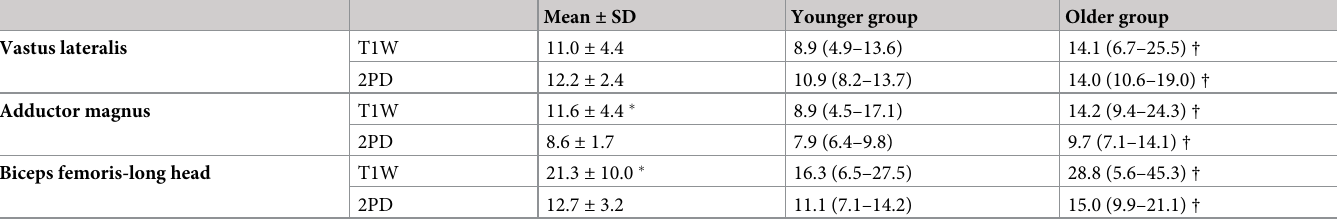
Table 1. Effect of analysis order on intramuscular adipose tissue content (IntraMAT content; %) in T1W and 2PD